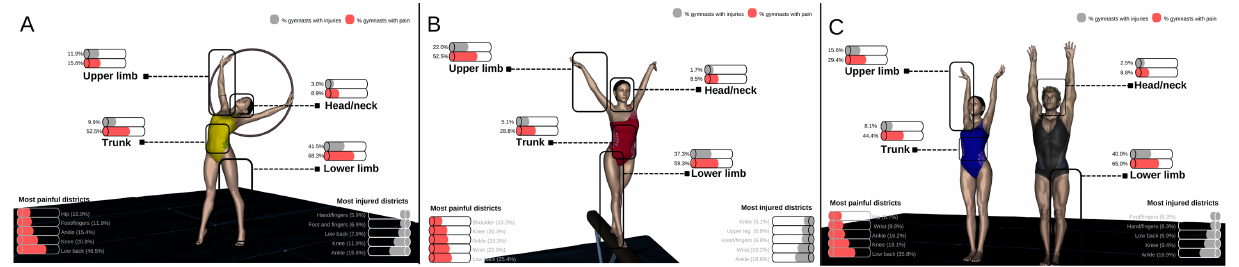
Figure 1. Prevalence of injuries and pain according to the anatomical district affected. ( A ) Male and female rhythmic gymnasts; ( B ) male and female artistic gymnasts; ( C ) all male and female gymnasts. In terms of pain characteristics, 119 gymnasts (74.4%) reported having pain in at least one anatomical location at the time of evaluation (mild pain, 12.6%; moderate pain, 66.4%; and severe pain, 21.0%), with an average peak pain level of 4.4 ± 3.0 points. The most frequent painful locations were the low back (35.8% of all gymnasts), knee (19.1% of all gymnasts), ankle (16.2% of all gymnasts), and wrist (9.8% of all gymnasts) (Figure 1C). According to gymnastics disciplines, 77.2% of rhythmic gymnasts and 69.5% of artistic gymnasts had pain in any location (Table 1). Although the most frequent painful location was the low back among rhythmic (46.5%) and artistic gymnasts (25.4%), significant dif- ferences were found between both disciplines in the low back ( p = 0.003) and wrist (4.0 vs. 22.0%, respectively, p = 0.011) (Figure 1A,B). Supplemental File shows detailed data on the percentage of gymnasts with injuries and pain, according to anatomical location and